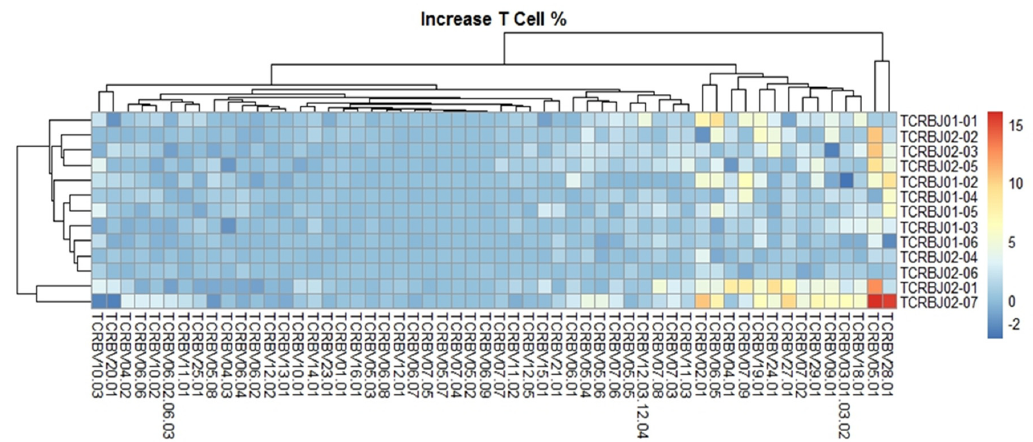
Figure 4. Comparison of the average TCRB V-J gene utilization between the day of admission and delayed cerebral ischemia (DCI). V gene and J gene segments are arranged on the x-axis and the y-axis, respectively. Different colors represent differences in the mean gene frequencies between the two different periods. Among 728 annotated V-J pairs, two V-J pairs, TCRBV28-01/TCRBJ02-07 and TCRBV05-01/TCRBJ02-07, were increased by more than 15% from the day of admission to DCI.